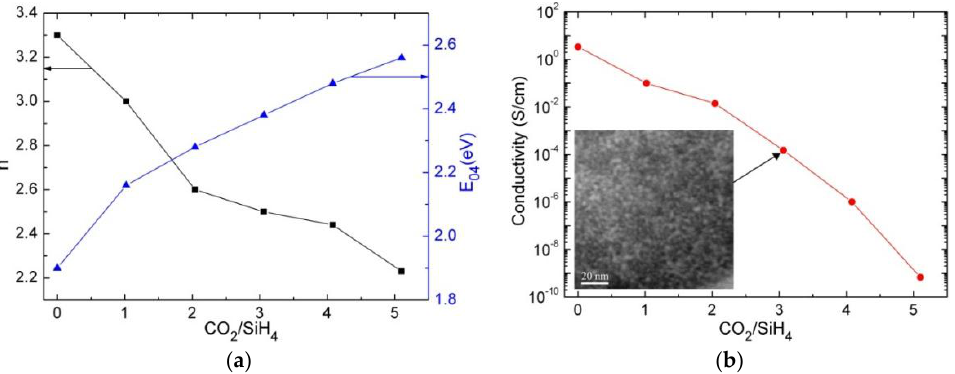
Figure 5. Optical, electrical and structural properties of n-type nc-SiO x :H samples grown with different CO 2 /SiH 4 flow rate ratio: ( a ) refractive index at ~500 nm (black symbols, left axis) and E 04 parameter (blues symbols, right axis); ( b ) planar electrical conductivity and energy filtered transmission electron microscopy (EFTEM) plan-view image of the sample deposited with CO 2 /SiH 4 = 3 (the Si phase appears as white and the O-rich phase as dark in the image).